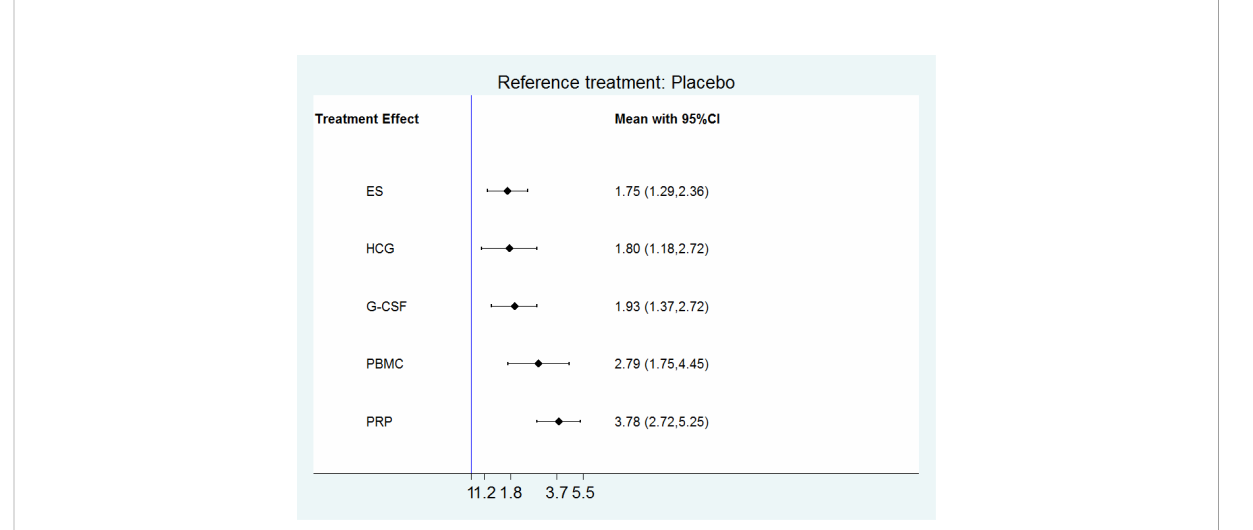
FIGURE 3 The results of the network meta-analysis for clinical